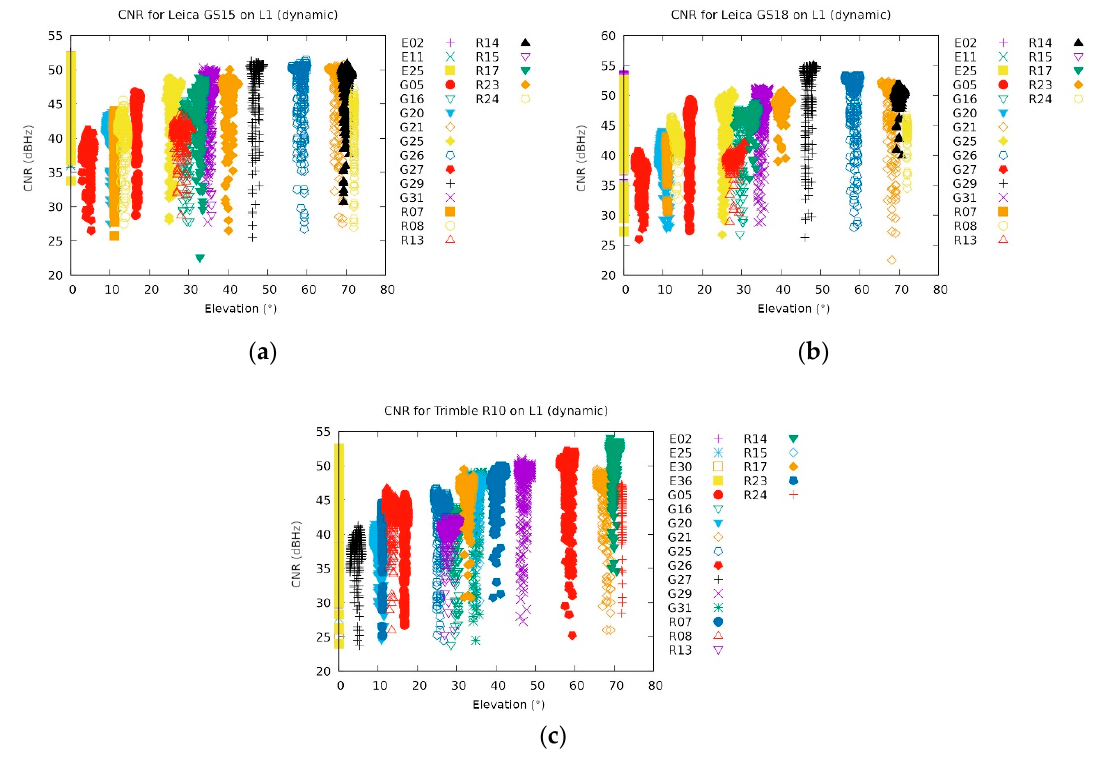
Figure 15. Carrier-to-noise ratio during the dynamic jamming for the Galileo ready receivers: ( a ) Leica GS15, ( b ) Leica GS18 and ( c ) Trimble R10 (the two Javad’s instruments are not shown since they ignored Galileo because it was not operational). All the Galileo satellites (annotation E in front of the